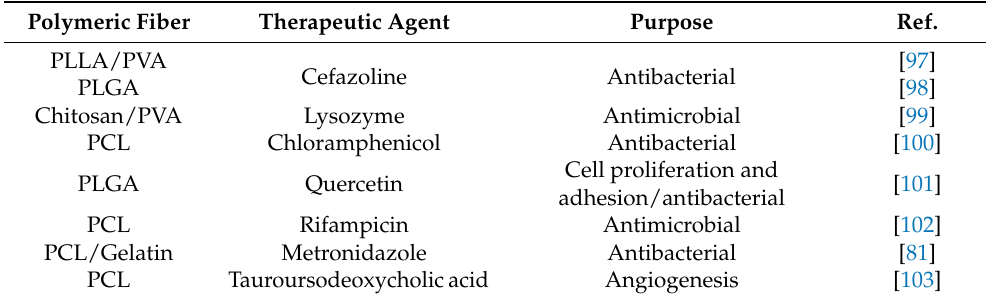
Table 2. Therapeutic agents loaded into electrospun NF implants to promote wound healing. Polymeric